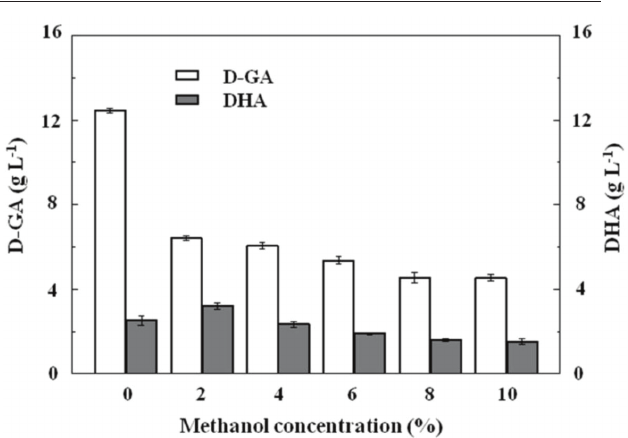
Fig. 5 – Effect of methanol on the yield of D-GA and